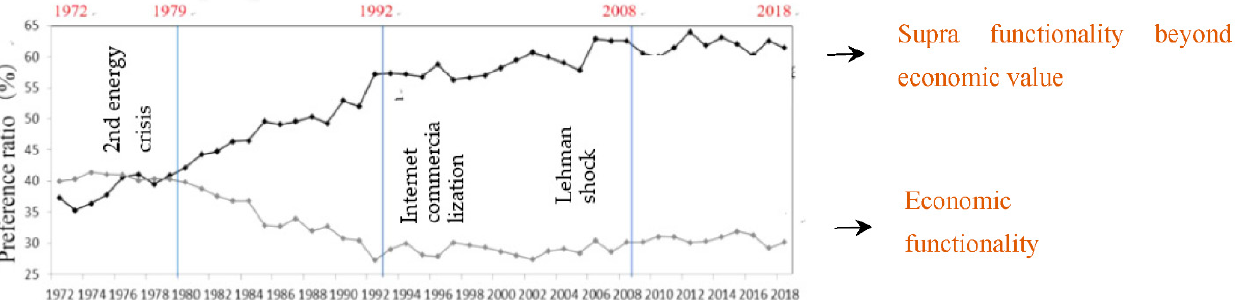
Figure 2. The trend in the shift of people’s preferences in Japan (1972–2018). Source: National Survey of Lifestyle Preferences [50].